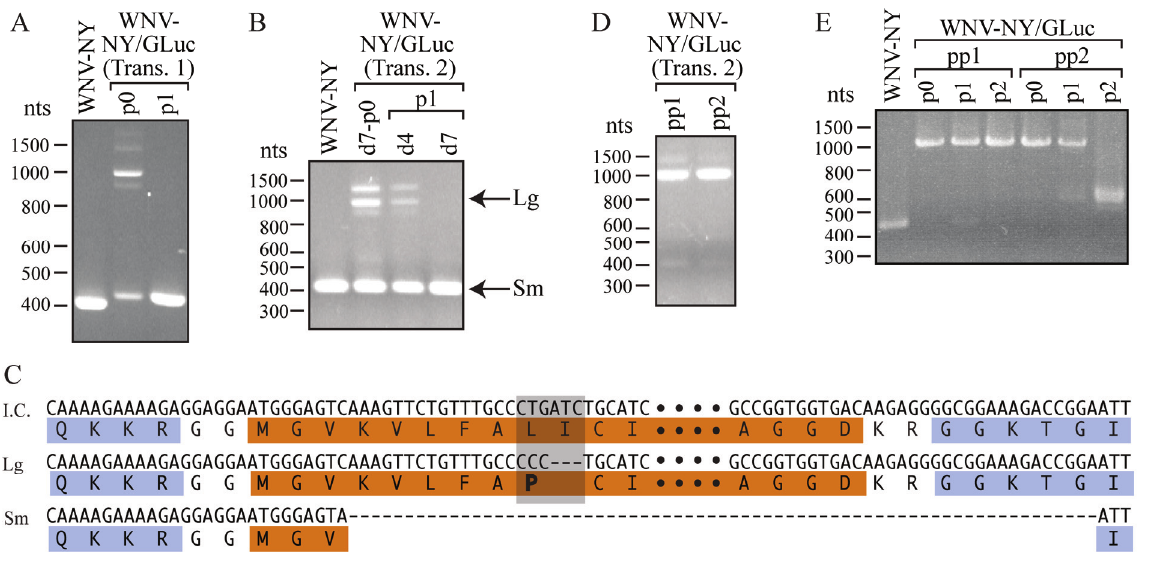
Figure 4. Characterization of WNV-NY/Gluc. ( A ) RT-PCR analysis. RNA extracted from cells transfected with WNV-NY/TAT RNA (p0) and cultures infected with the p0 stock (p1) were used as templates for RT-PCR amplification of the WNV C/CA region (WNV nts 97-500). RNA recovered from cultures infected with wild-type WNV-NY was used as a positive control. DNA molecular size standards (in nts) are indicated on the left; ( B ) RT-PCR analysis of passaged WNV-NY/Gluc. Vero cells were transfected with infectious WNV-NY/GLuc RNA. A portion of the culture supernatant (p0) was collected after 4 days (d4). The remaining supernatant and total RNA was collected at 7 days (d7) post-transfection. Total RNA was extracted from Vero cells infected with d4 or d7 p0 stocks (d4-p1 and d7-p1). Extracted RNA was used as template for RT-PCR as described in Panel A; ( C ) Sequences. The d7 p0 large (Lg) and small (Sm) PCR products (Panel B) were sequenced by GeneWiz. The sequence encompassing the GLuc-encoding region of the WNV-NY/GLuc infectious clone (I.C.) is shown at the top. The amino acid sequence is shown below with WNV residues indicated in blue and GLuc residues in orange. Bullets represent additional GLuc residues that are not shown but are present in the I.C. and Lg product. The gray box highlights the residues that are different between I.C. and Lg; ( D ) Plaque purification of WNV-NY/Gluc. The d4 p0 stock (Panel B) was also used to inoculate a confluent monolayer of Vero cells, which were then overlaid with 0.9% agarose/DMEM. After 4 days, two plaques (pp1 and pp2) were picked, incubated with 1 mL DMEM, and used to inoculate Vero cells. After an additional 4 days, culture supernatants were collected. RNA was extracted from the infected Vero cells and used as template for RT-PCR as described in Panel A; ( E ) RT-PCR analysis of pp1 and pp2 serial passages. The pp1 and pp2 viruses were passaged twice in Vero cells to generate p1 and p2. RNA extracted from the infected Vero cells was used as template for RT-PCR as described in Panel